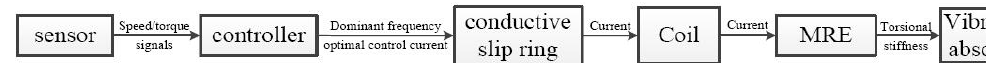
Figure 7. Power supply process of the MRE vibration absorber.